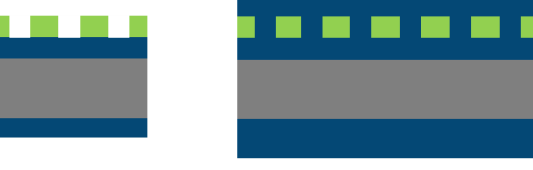
Figure 1. Poly-Si microhotplate fabrication process flow .